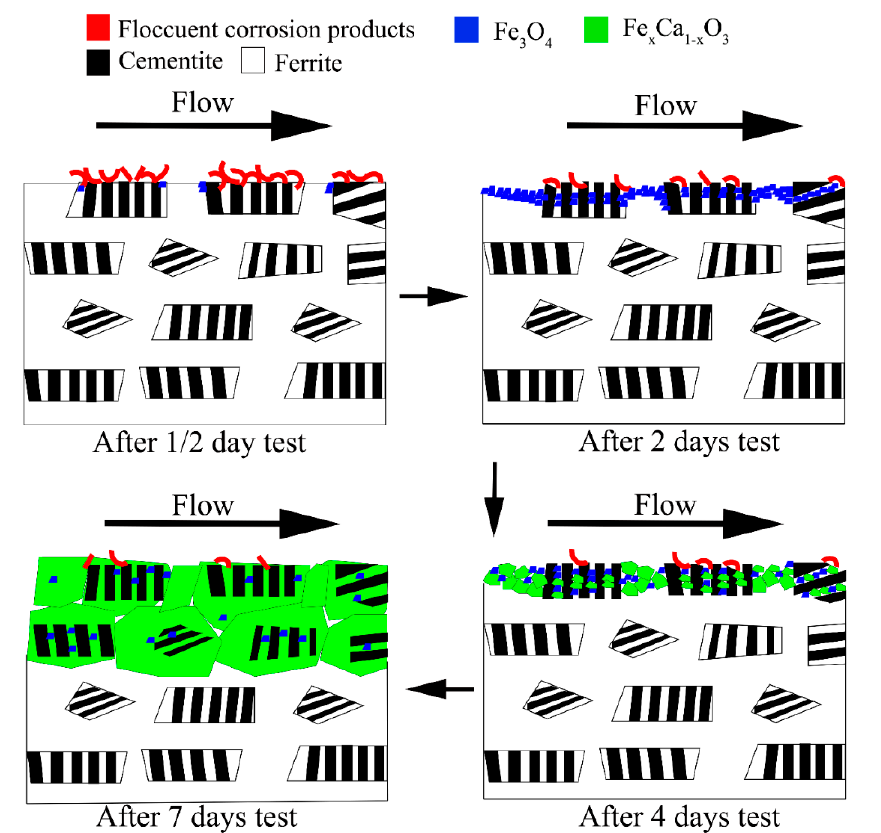
Figure 16. The corrosion process with time under flow condition.